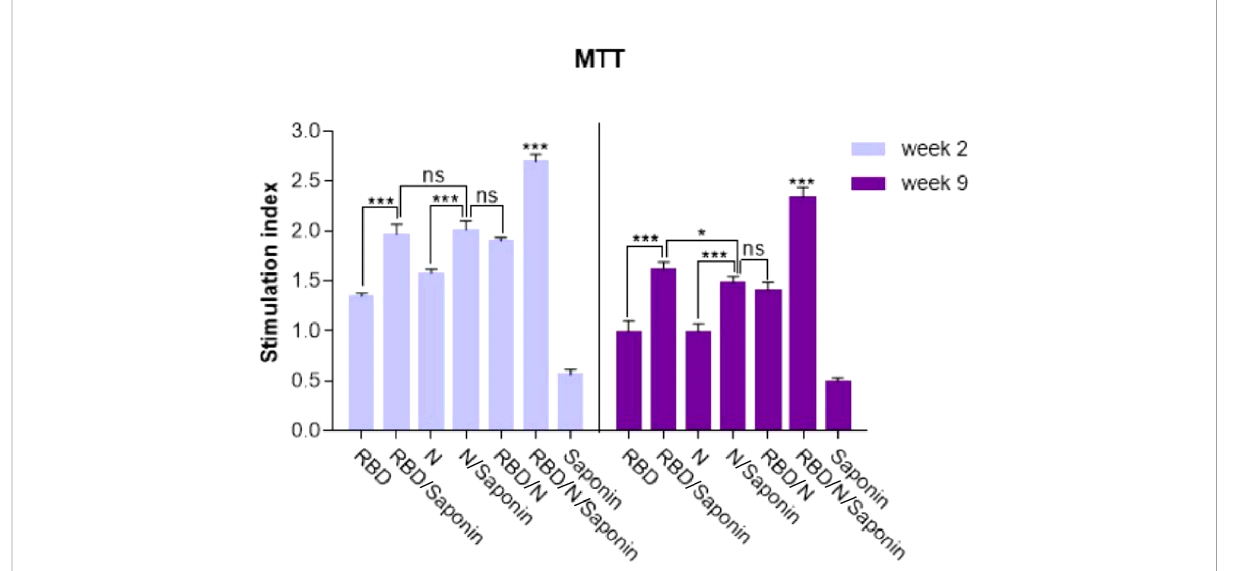
FIGURE 6 Proliferation of immunized BALB/c mice splenocytes after in vitro re-stimulation with synthetic RBD/N speci fi c epitope. Splenocytes from mice were harvested two and nine weeks after the last immunization and lymphocyte proliferation was evaluated by the MTT assay. Results represent the mean ± SD of 3 mice per groups. *** Indicates statistically signi fi cant differences between the RBD/N plus saponin adjuvant compared with other groups as determined by one-way ANOVA (P < 0.001). * for P <0.05, and ns for a nonstatistical